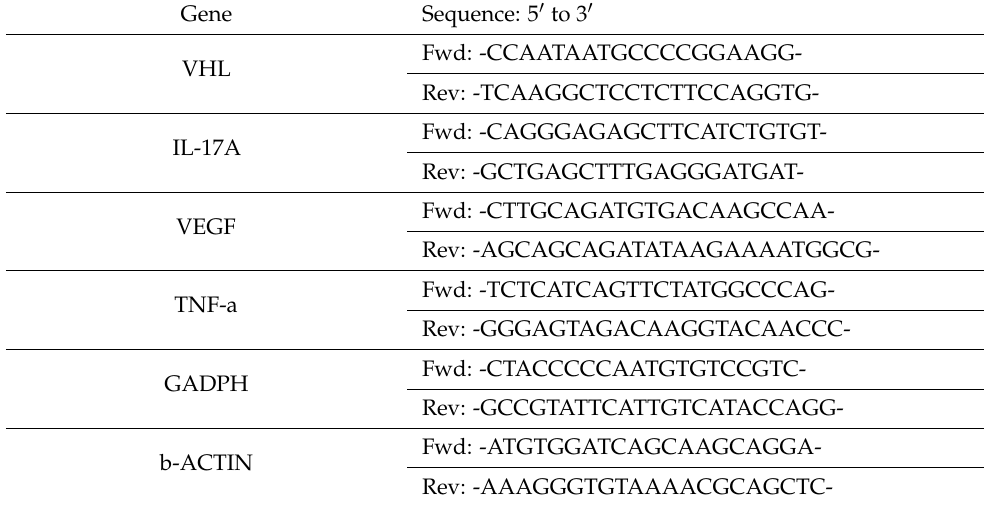
Table 1. Primers used to perform RT-PCR